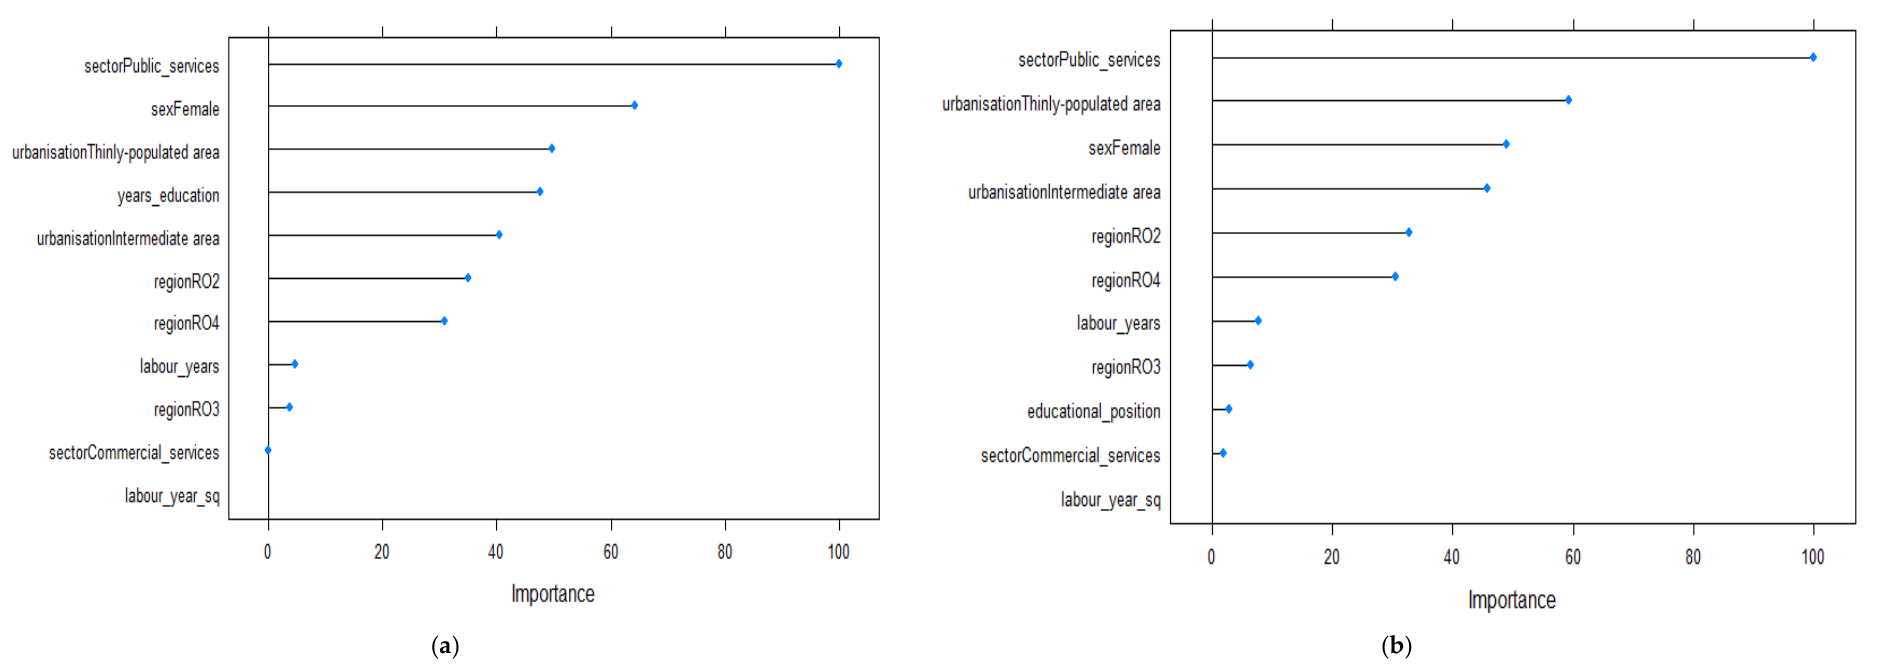
Figure 5. Relevant variables in explaining the variations in wages based on the Enet method for the 45 – 54 year old age group ( n = 2033): ( a ) model 1 using the absolute measure of education; ( b ) model 2 using the relative measure of education.